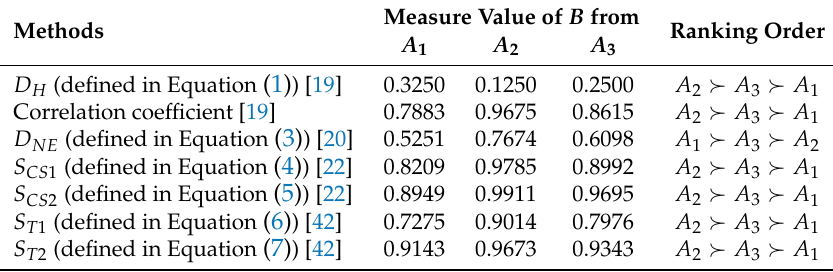
Table 1. Ordering value of Example